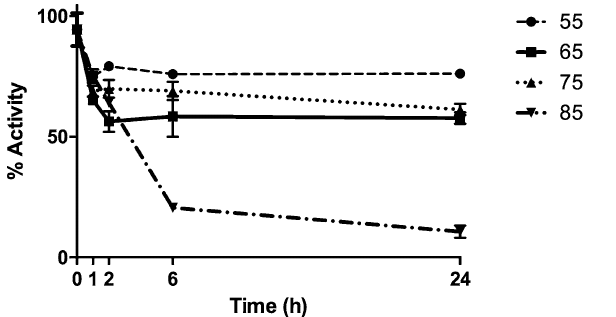
Figure 4. Effect of temperature on the stability of purified pTsbg. Graphic was created using GraphPad Prism 6 for Windows (GraphPad Software, San Diego, California USA, www.graph